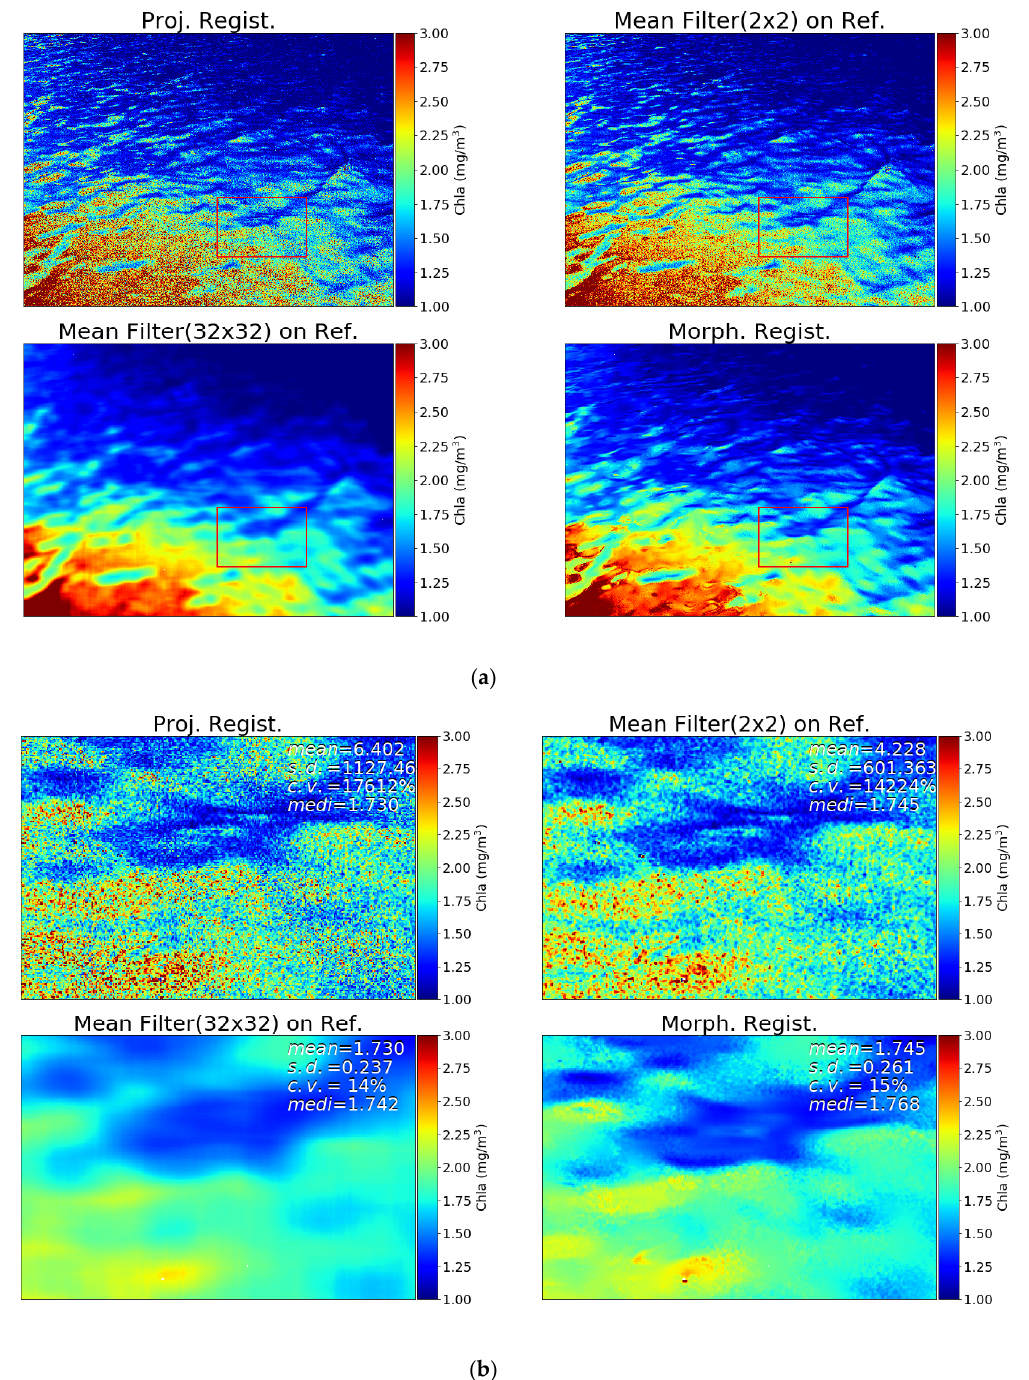
Figure 15. Scene-B, acquired on 2019.08.31 at an altitude of 8.1 m. ( a ) Chla estimates from four di ff erent processings of R rs data; ( upper left ) before morphological registration, ( upper right ) after 2 × 2 mean filter on water reflectance, ( bottom left ) after 32 × 32 mean filter on water reflectance, and ( bottom right ) after morphological registration. ( b ) Magnified figures for the subset area marked in a red box in panel ( a ).